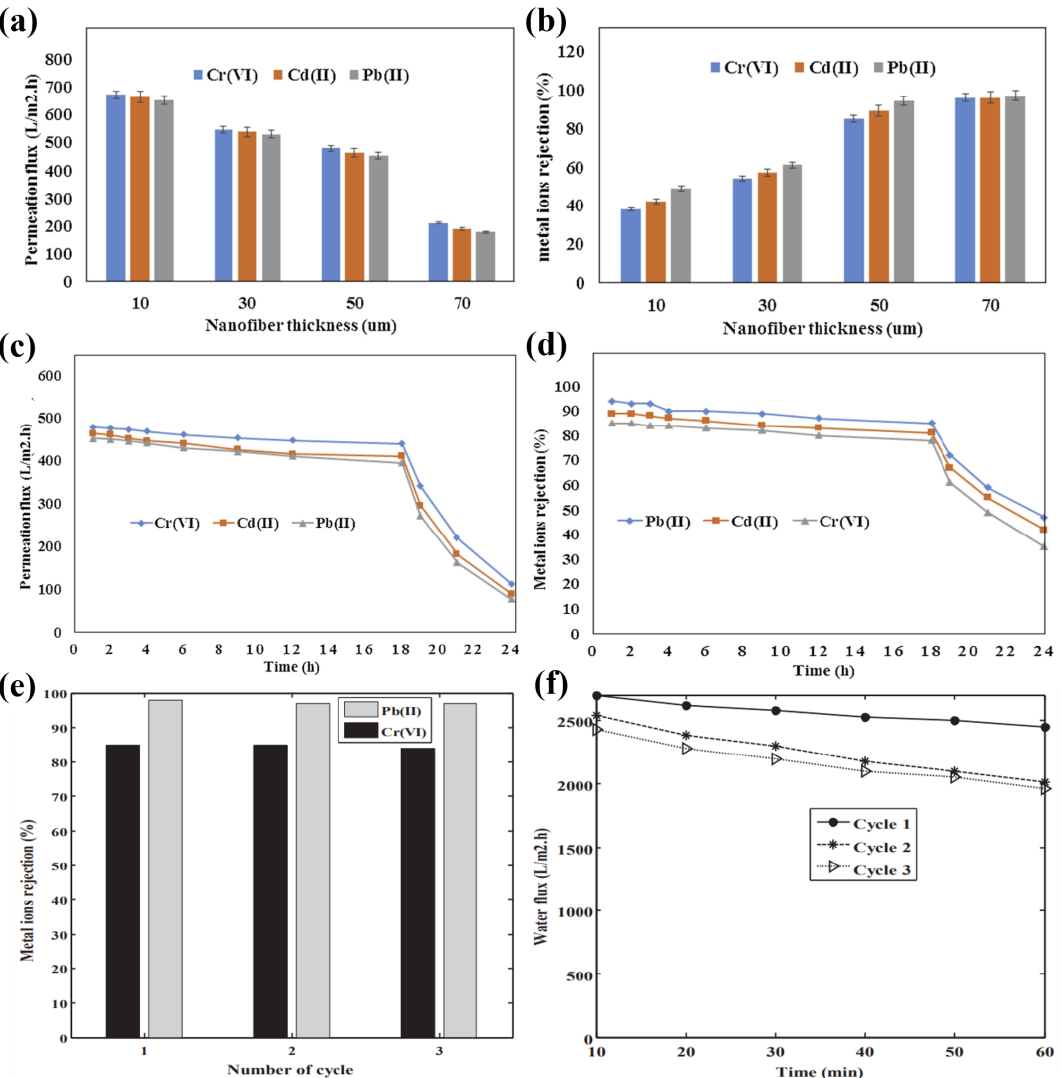
Figure 9. The effect of PAN/chitosan/UiO-66-NH 2 nanofiber layer thickness on the removal of ( a ) flux and ( b ) metal ions using PVDF/PAN/chitosan/UiO-66NH 2 nanofiber membrane, ( c ) permeation flux, and ( d ) removal efficiency of metal ions in the nanofiber membrane within 24 h. Reprinted with permission from ref. [64]. Copyright 2019 Elsevier; ( e ) regenerating metal on the PES/PVA/chitosan/A-Fe 3 O 4 -2 nanofiber membrane ion recovery rate; and ( f ) the influence of water flux. Reprinted with permission from ref. [100]. Copyright 2018 Elsevier.